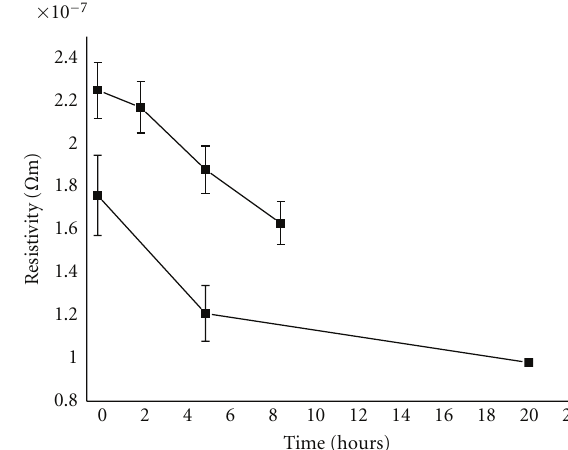
Figure 4: Charging time dependence of resistivity in titanium